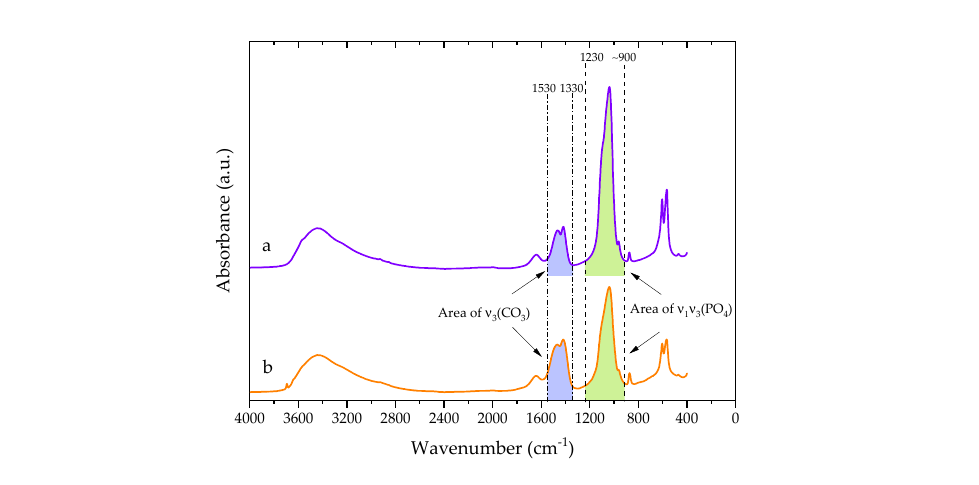
Figure 3. FT − IR transmittance spectra of nHAp powder (a) 1DP − nHAp and (b) 2DP − nHAp.